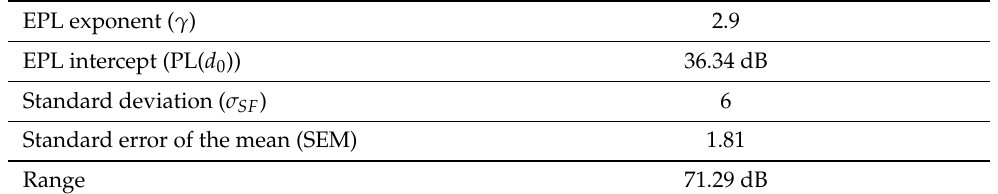
Table 2. Lognormal PL Model parameters in the outdoor environment and statistical measures.